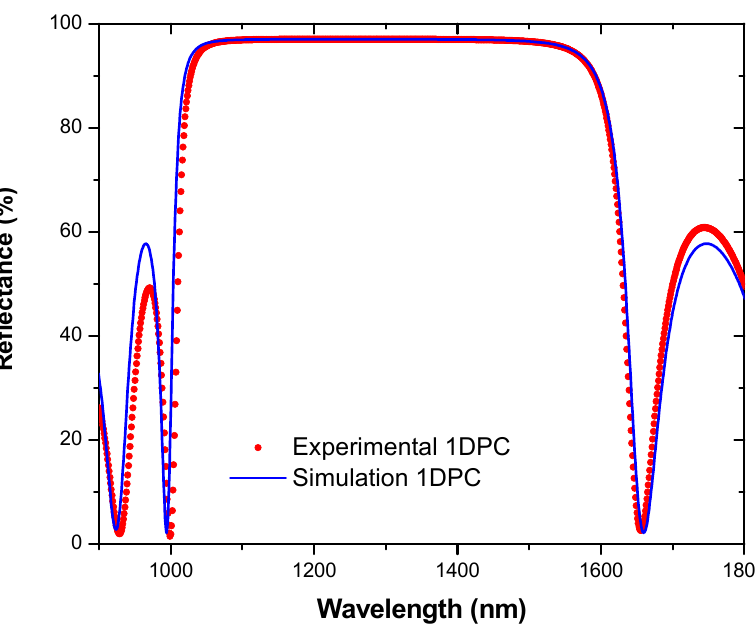
Figure 6. Bragg peak characteristics for the 1DPC SiO 2 /TiO 2 designed for reflecting the NIR solar spectrum. Red dots correspond to the experimental reflectivity characterization, and the blue line is the simulated optical response.